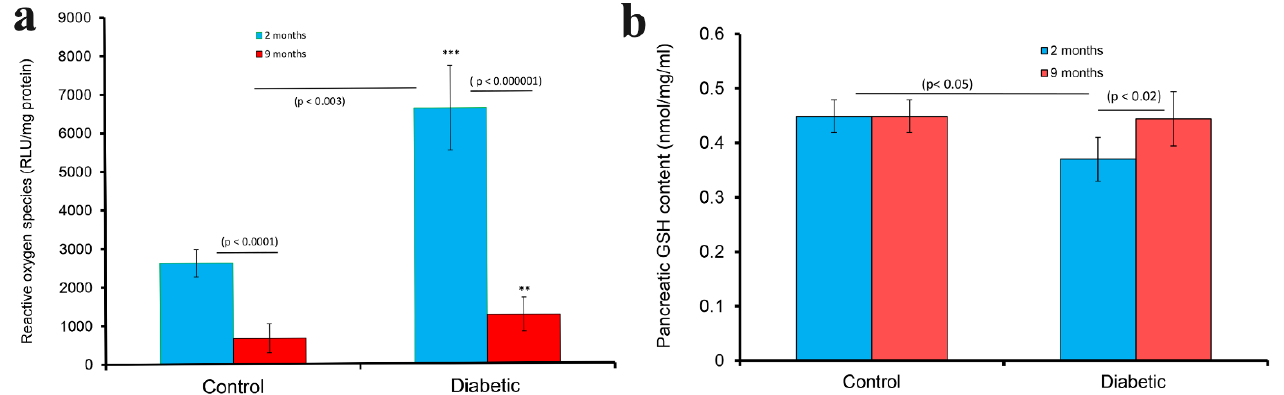
2 (blue) and 9 months (red) after the onset of diabetes. ROS was also determined in age-matched controls. ROS was significantly (*** p < 0.004) higher after the onset of diabetes lasting 2 months. ROS was significantly (** p < 0.03) higher after the induction of diabetes that lasted 9 months but less dramatic compared to those of diabetes of a shorter duration. ROS was significantly higher in the pancreas of 2-month-old rats in both normal ( p < 0.0001) and diabetic ( p < 0.000001) conditions compared to that of 9-month-old rats ( a ). ( b ) shows the histogram of glutathione (GSH) in the pancreas of diabetic rats 2 (blue) and 9 months (red) after the onset of diabetes. GSH was also determined in age-matched controls. While the GSH level of pancreatic tissues was significantly ( p < 0.05) reduced 2 months after the induction of diabetes, that of 9-month-old rats approached control level. The pancreatic GSH content of rats with 9-month-old diabetes was significantly ( p < 0.02) higher than those with 2-month-old diabetes (n =